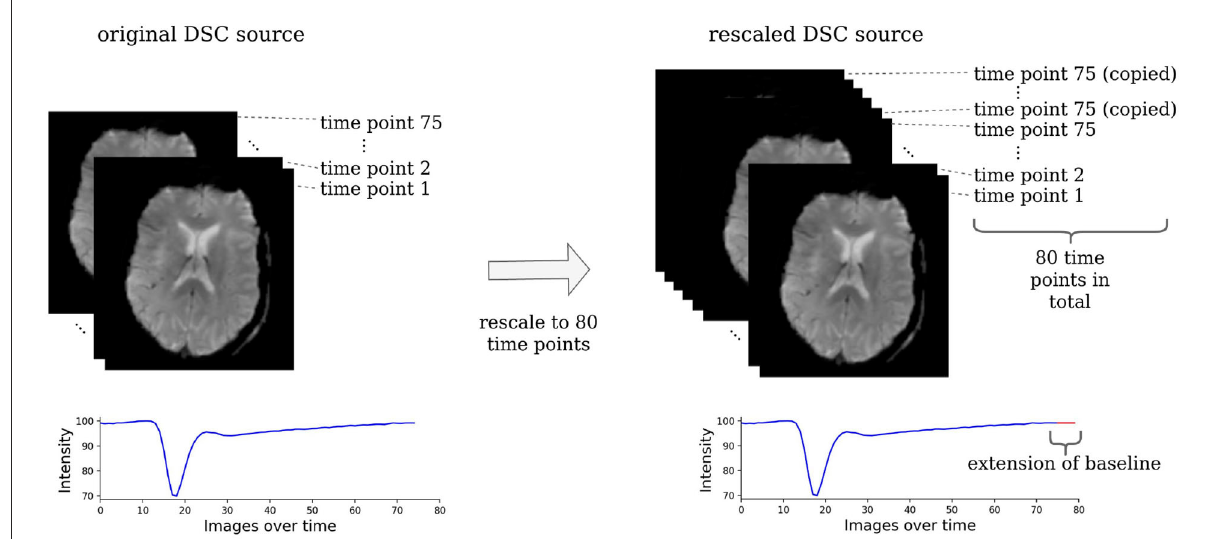
FIGURE2 Rescaling of the DSC source images. The DSC source images need to be rescaled to the same dimension to be suitable for a machine learning-based analysis. For this, all images that consisted of less than 80 time points were rescaled by copying the image of the last time